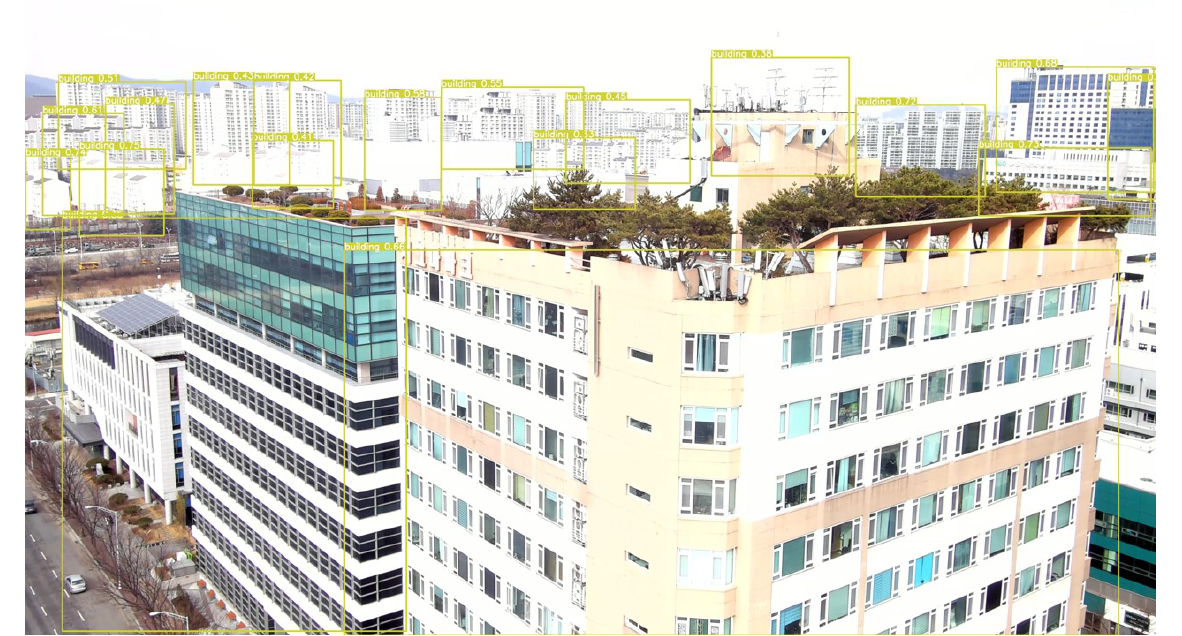
Figure 9. The results of the 20 M, 40 M, and 60 M detections. A variety of objects are detected, such as people, vehicles, trees, and buildings. However, when creating avoidance routes, small objects do not need to be detected, making the model slower at